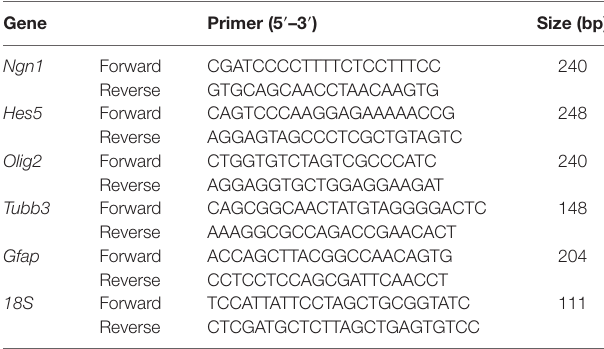
TaBle 2 | Primers used for the gene expression profile of differentiating aOBscs by